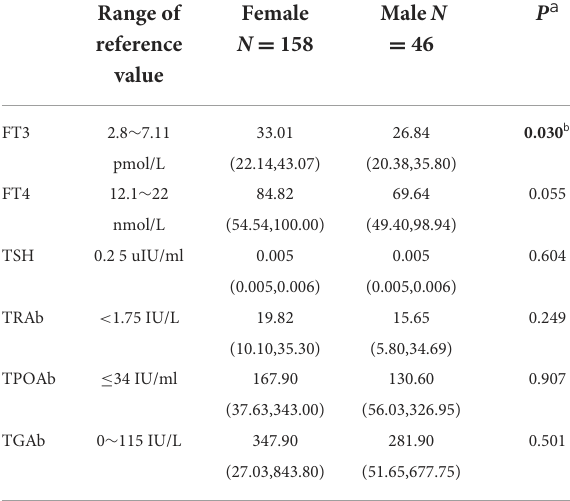
TABLE 4 Comparison of thyroid hormone and thyroid antibodies levels between different sexes in GD. Range